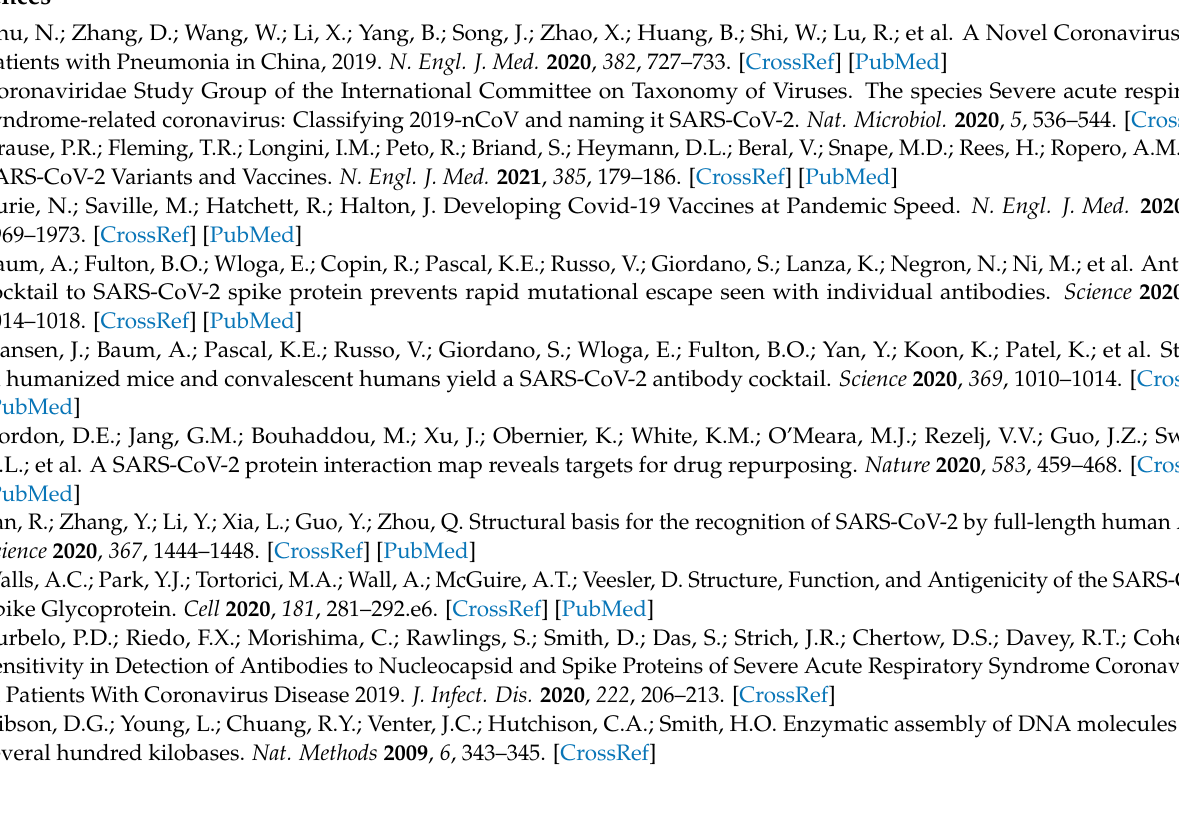
Figure S4. Immunofluorescence of untransfected cells to show specificity of the N and S antibodies to their respective